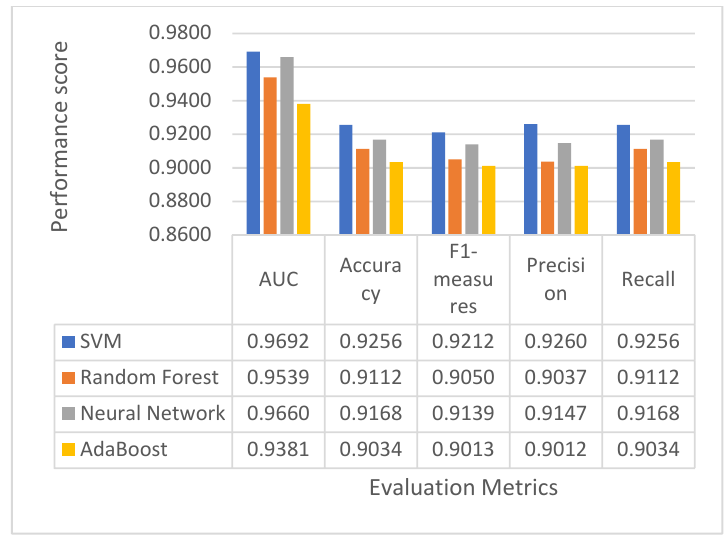
Figure 7. Performance of four classifiers using the breast ACPs.